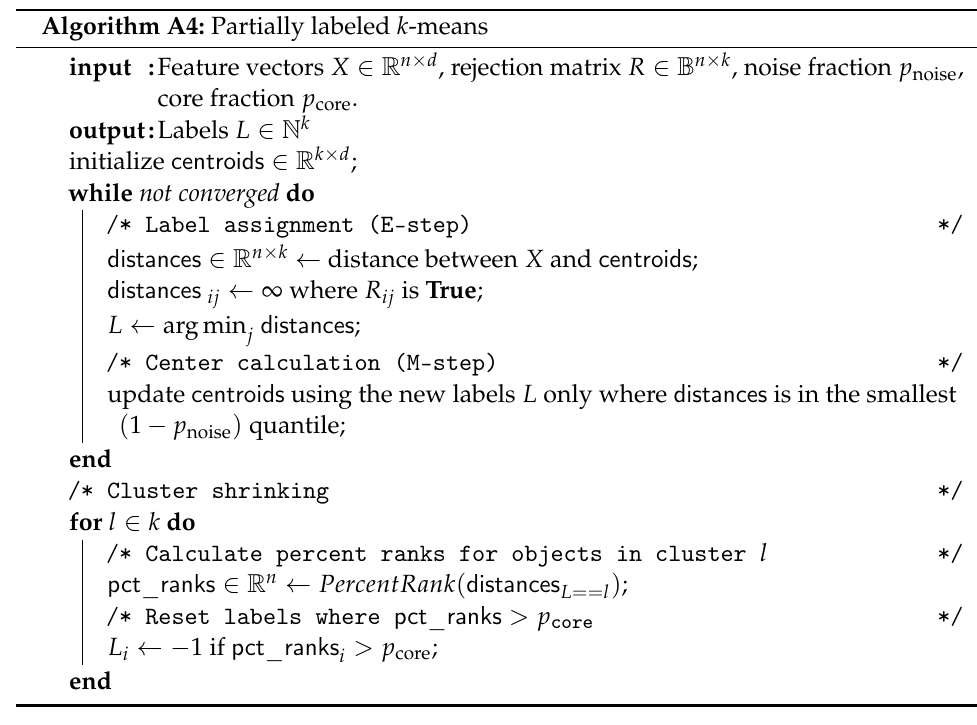
Algorithm A4: Partially labeled k